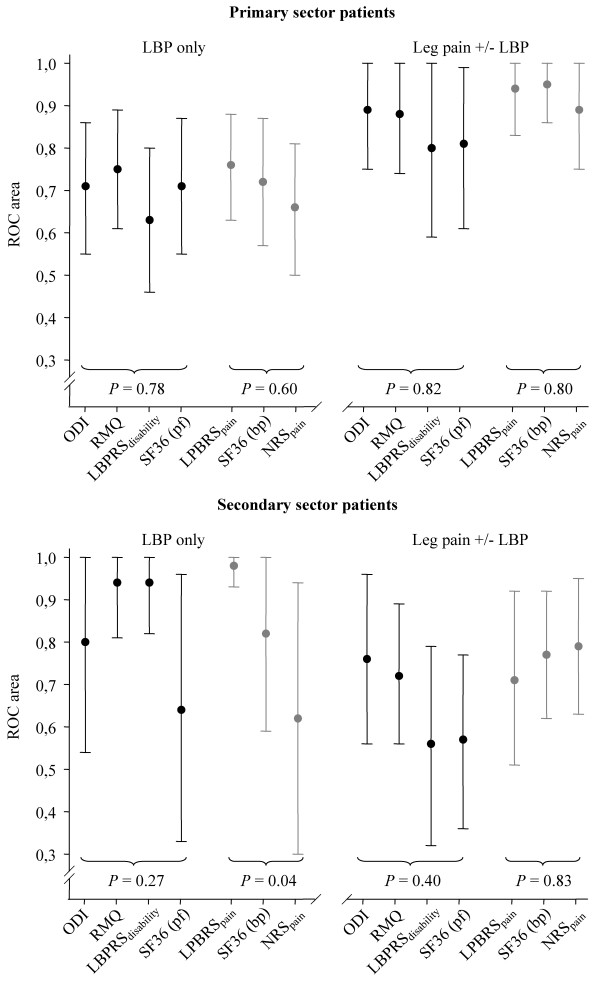
Area under the ROC curve (with 95% confidence intervals) in primary and secondary sector patients according to pain location.